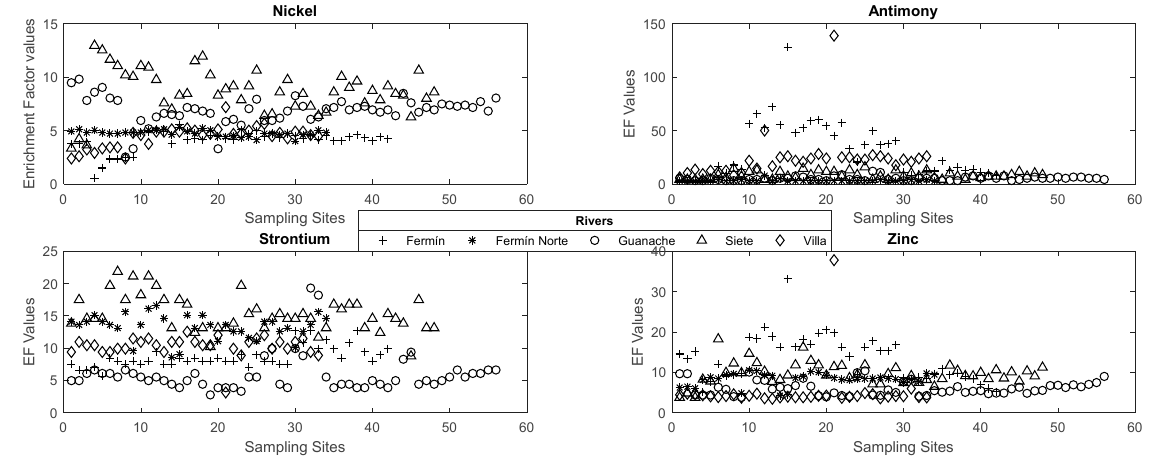
Figure 4. Downstream longitudinal sequence of EF for Ni, Sb, Sr and Zn.